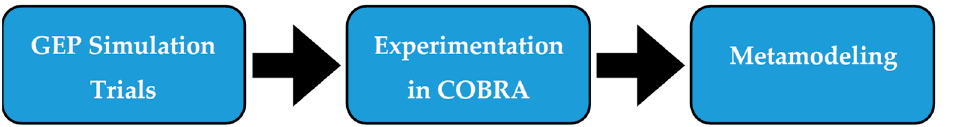
Figure 1. Metamodeling Procedure Flowchart. GEP: generation expansion planning; COBRA: co-benefits risk assessment.